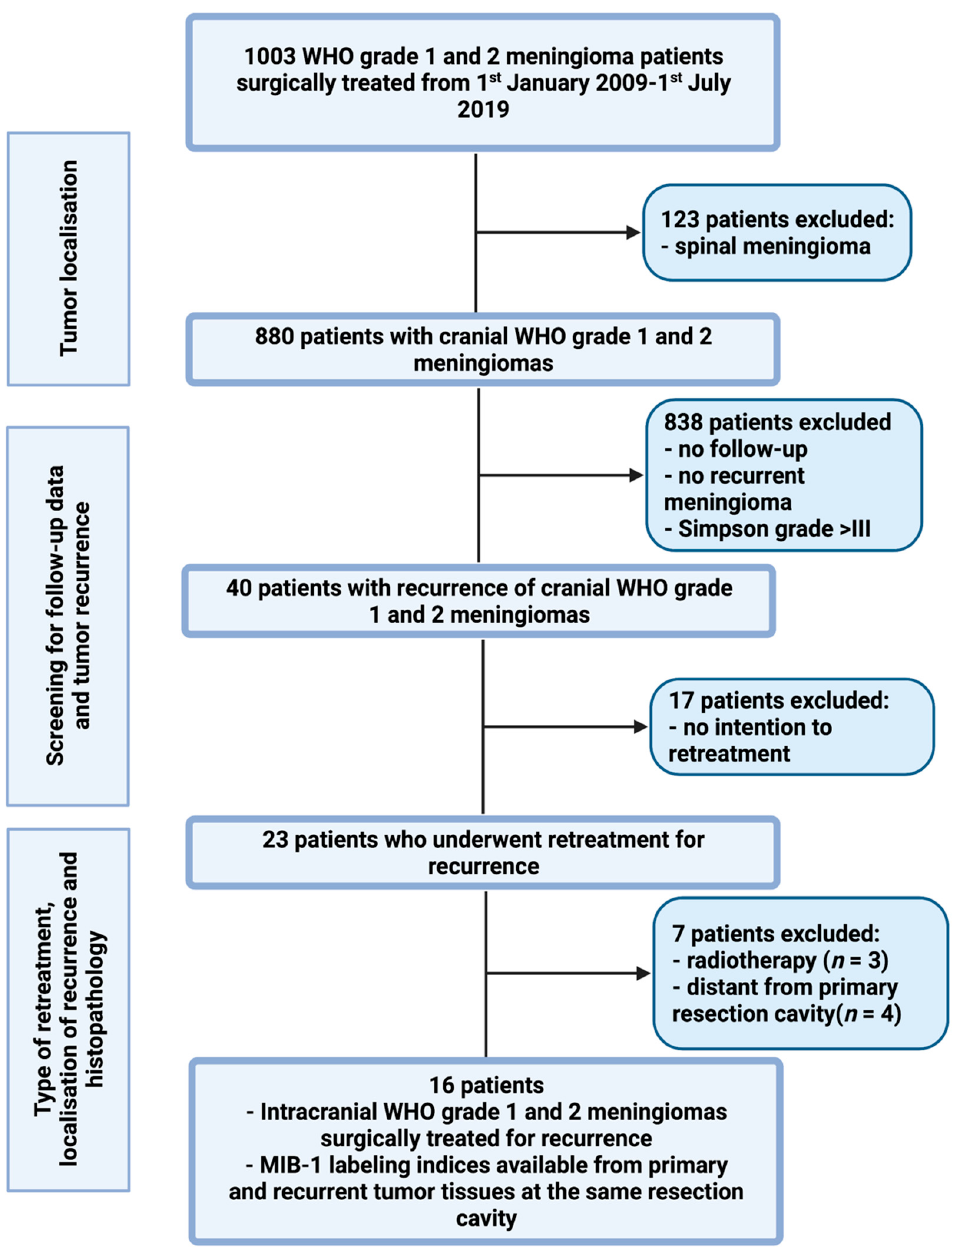
Figure 1. Flow chart illustrating the selection process of consecutive meningioma patients between 1 January 2009 and 1 July